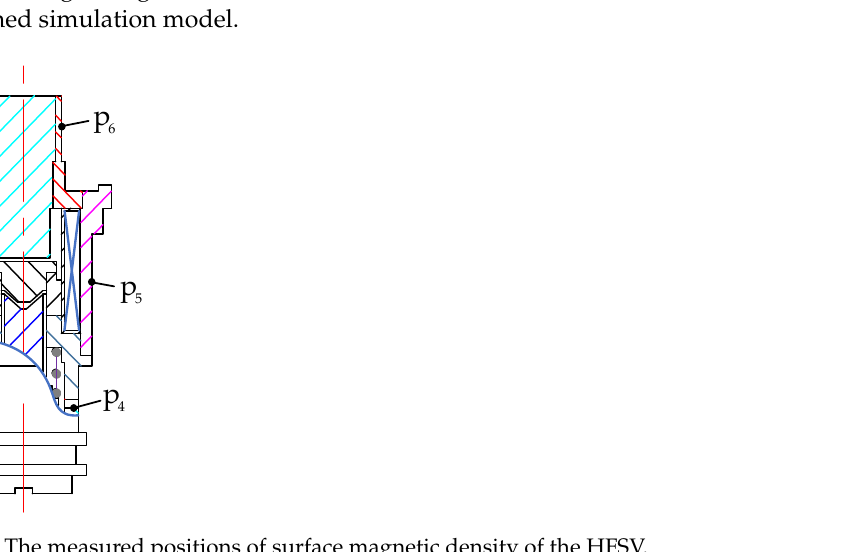
Figure 1. Structure diagram and magnetic field distribution of the HFSV.